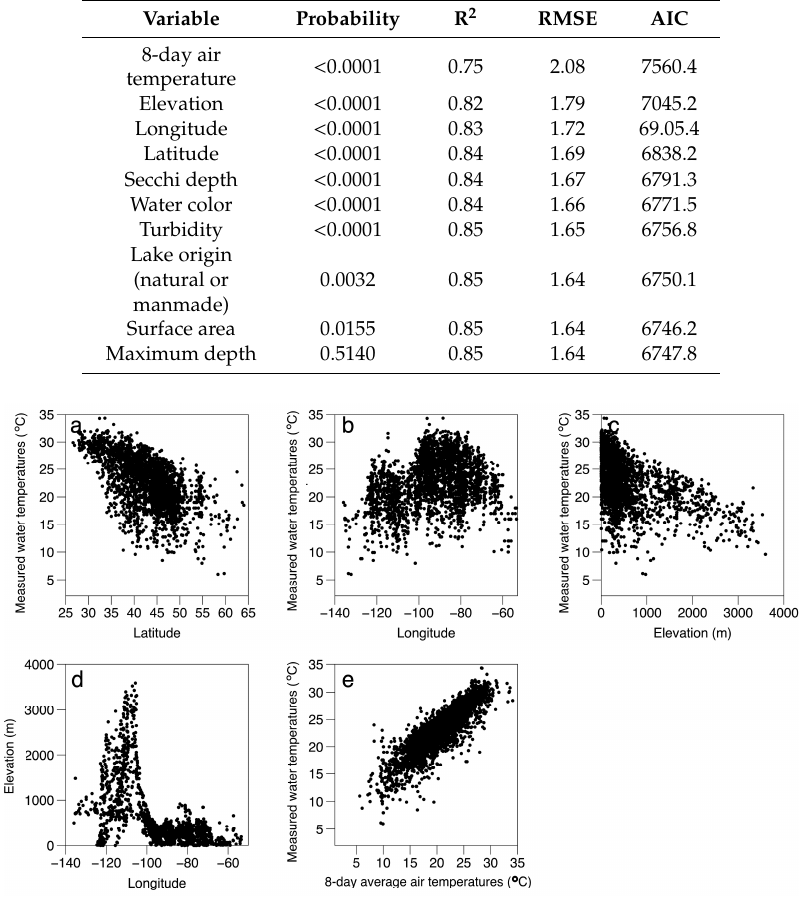
Figure 2. Measured water temperatures at 1 m for lakes in Canada and the United States sampled in the months of June, July, August and September plotted against each lake’s ( a ) latitude, ( b ) longitude and ( c ) elevation. ( d ) The elevations of the lakes in the sample are plotted against longitude. ( e ) The water temperatures are plotted against the 8-day average air temperatures for each lake.